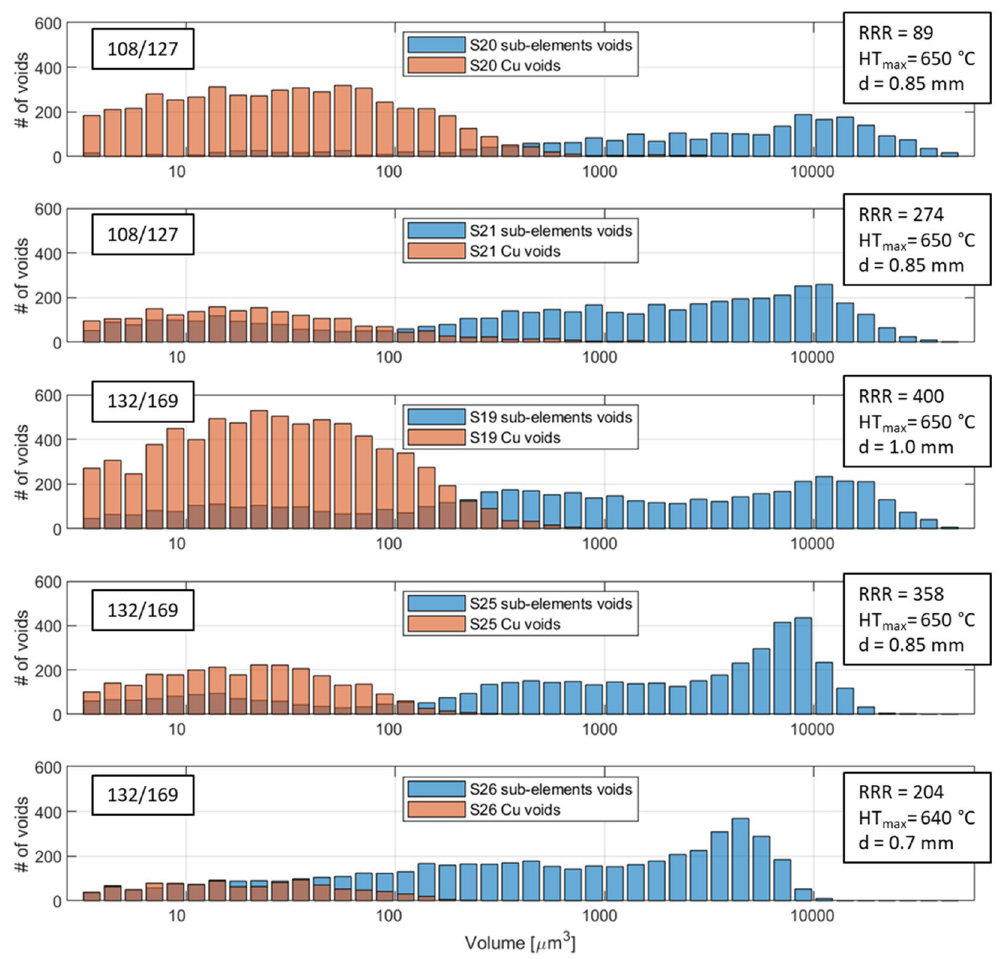
Figure 4. Distribution of the wires sub-element and copper voids as function of their